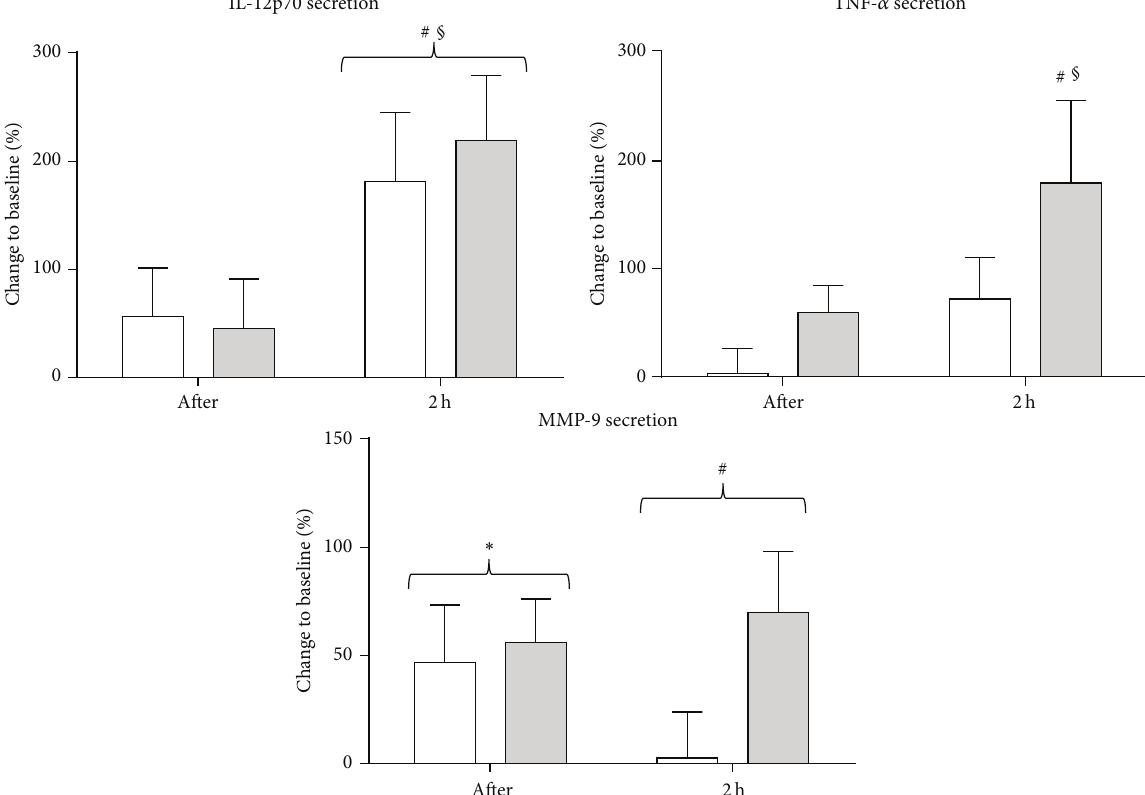
Figure 5: Increased secretion of inflammatory mediators upon TLR stimulation after one exercise bout. Blood samples of healthy controls (white bars) and MS patients (grey bars) were (i) stimulated overnight with LPS in combination with IFN- 𝛾 or (ii) left unstimulated. Secretion of inflammatory mediators was quantified using ELISA. For the secretion of TNF-alpha, only patients on 2nd-line treatment are depicted. Mean fold changes are calculated as the ratio of the secreted concentration in the stimulated condition to the nonstimulated condition. Then, % changes after exercise and after 2 hours of rest with respect to the baseline value are calculated. Results are shown as mean % change ± SEM. ∗ 𝑃 < 0.05 for the difference between results before and after the test. # indicates a significant effect between before and 2 hours after the test. § indicates a significant effect between after and 2 hours after the test. Abbreviations used are as follows: LPS: lipopolysaccharide; IL: interleukin; TNF: tumour necrosis factor; IFN: interferon; MMP: matrix metalloproteinase; after: measurement immediately after the test; 2 h: measurement 2 hours after the test; and SEM: standard error of the